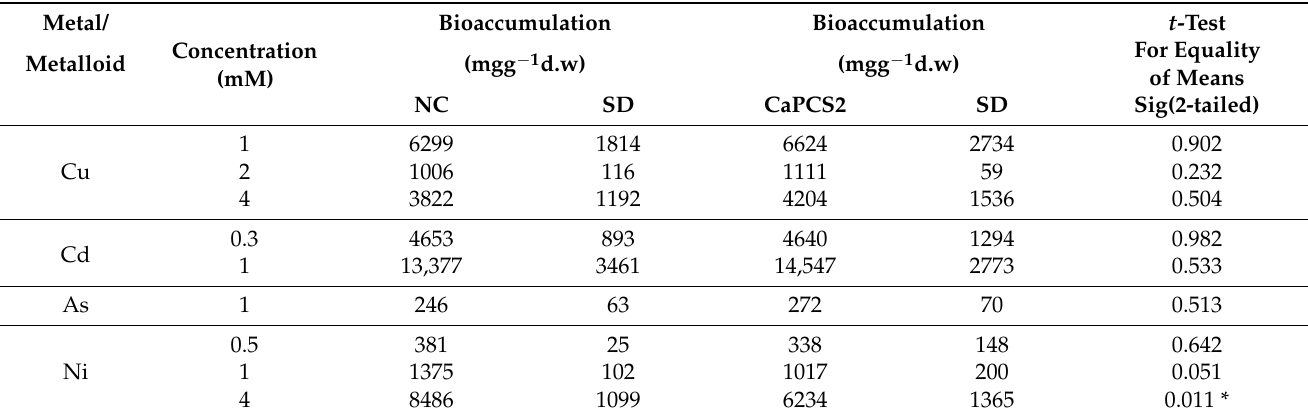
Table 1. Bioaccumulation of metal(loid)s in cells of E. coli NC and CaCPS2 strains quantified by ICP-mass technique expressed in mg g − 1 dry weight (d.w). Data expressed as the arithmetic mean of at least three assays. SD: standard deviation. Exposure time: 1 h.